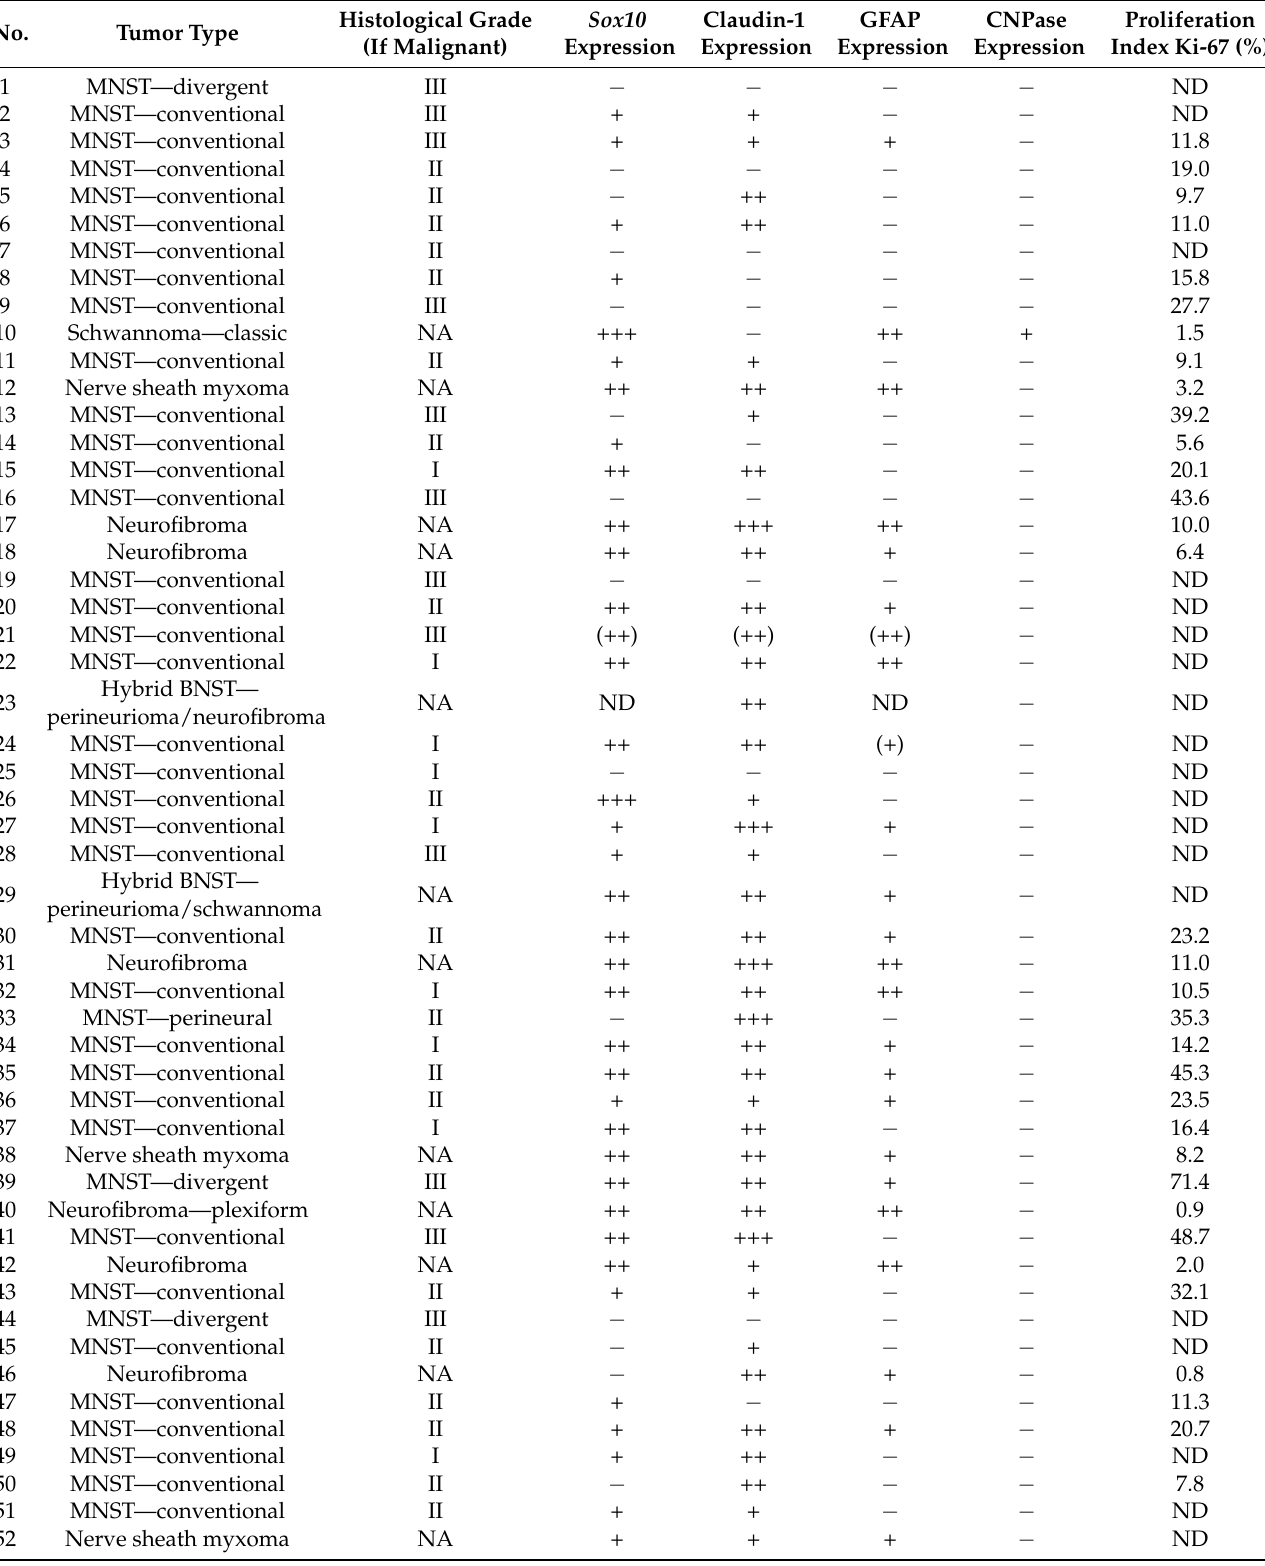
Table 4. Tumor types and results of immunohistochemical stainings for each examined